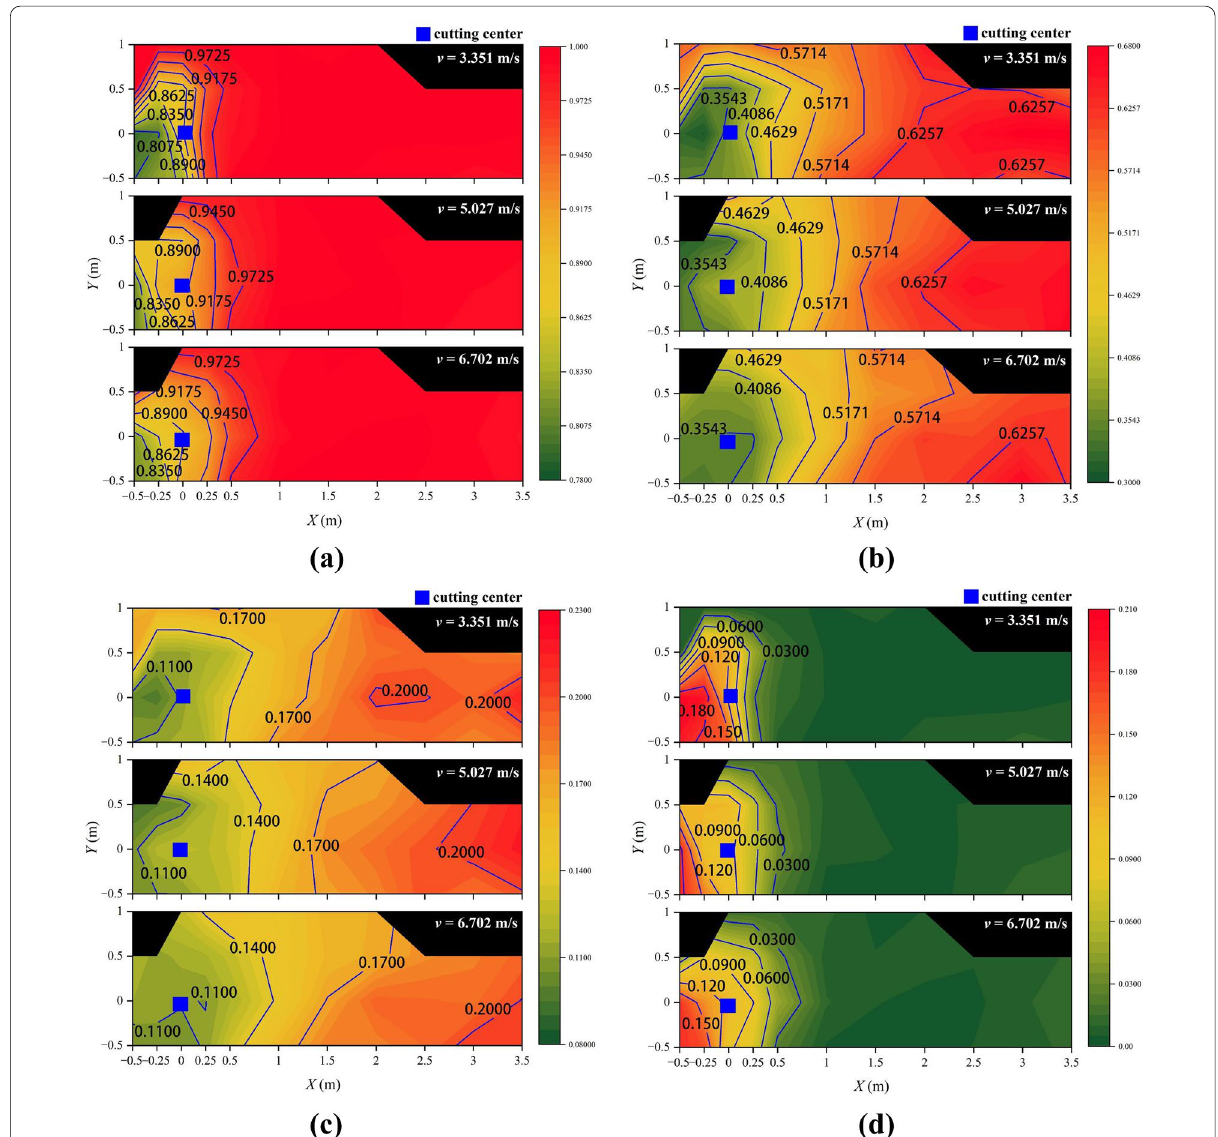
Fig. 6 The contour of number percentage of particles with a d eq < 100 μm (the inhalable fraction); b d eq < 25 μm (the thoracic fraction); c d eq < 10 μm (the respirable fraction); d d eq > 100 μm at different cutting